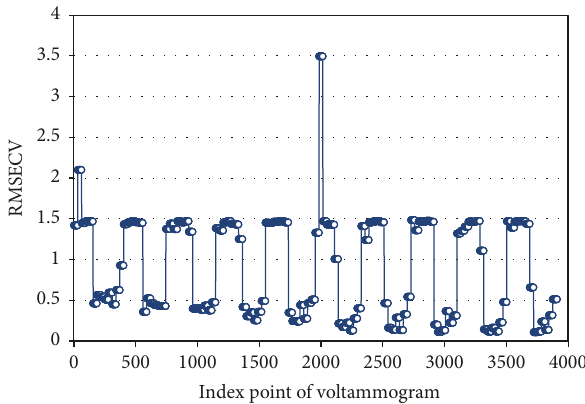
Figure 7: RMSECV calculated with IPCR for 125 nonoverlapping intervals of width of 31 variables and 1 interval of 36 variables of mean centered voltammograms for 𝐹 = 1 .